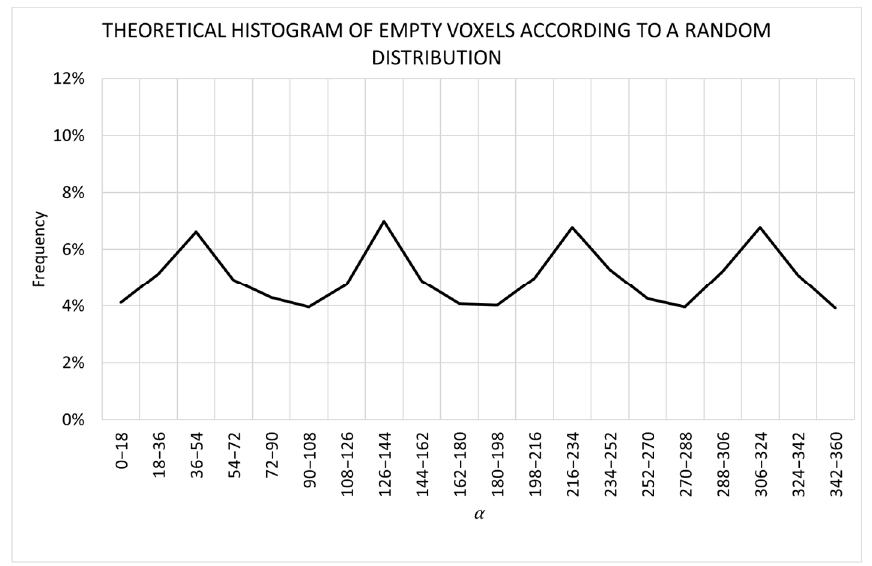
Figure 10. Radial test. Theoretical histogram of empty voxels according to a random distribution.